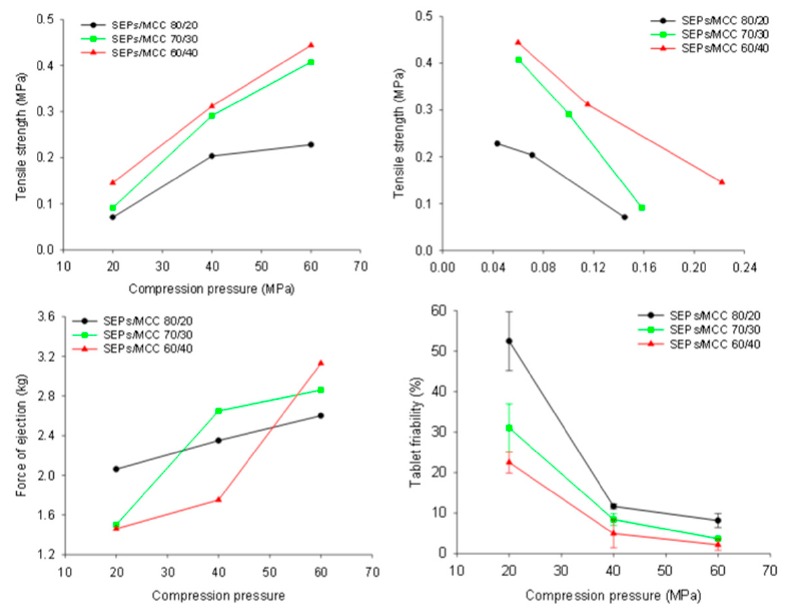
Figure 8. Plots showing: (a) tabletability, (b) compactibility, (c) ejectability, and (d) friability for different SEPs/MCC ratios (80/20 black circles, 70/30 green squares, 60/40 red triangles).